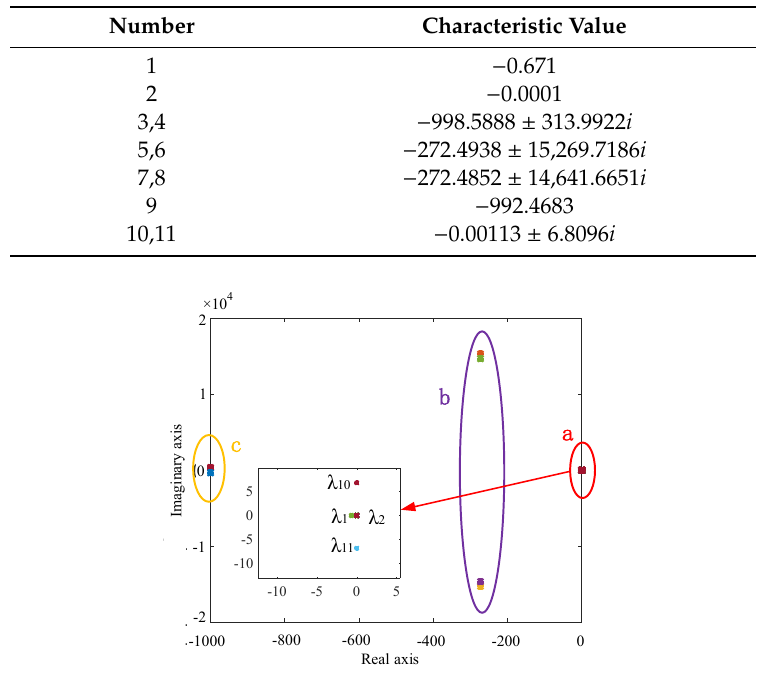
Figure 7. Distribution of the eigenvalues. Table 2. Eigenvalues of the microgrid.